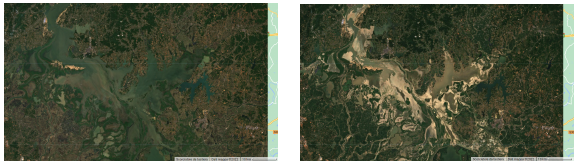
Figure 12. Sentinel-2 median image of Poyang lake on April-June 2022 (left) and on July-September 2022